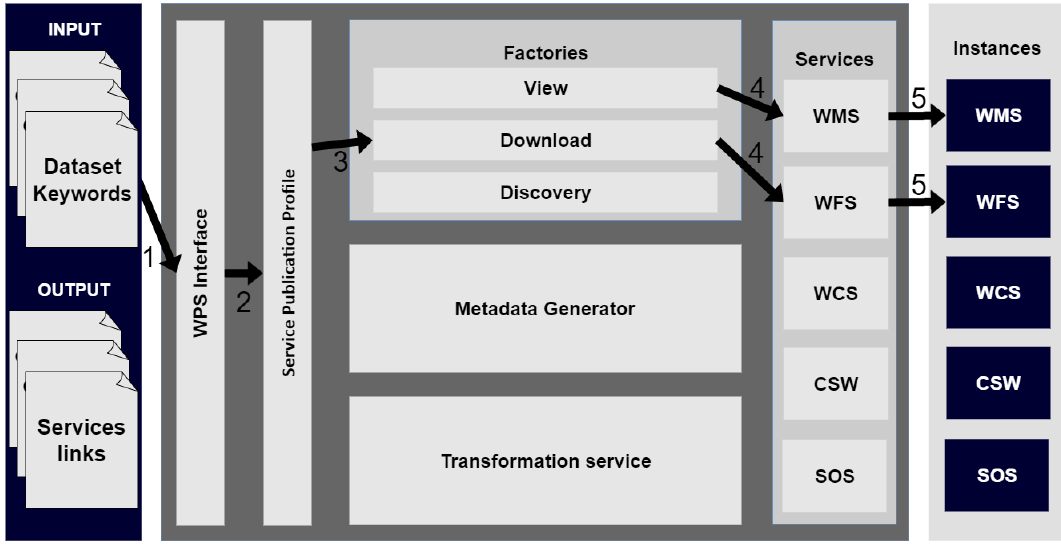
Figure 5. Different steps for publishing geospatial data using GSF. WMS: Web Map